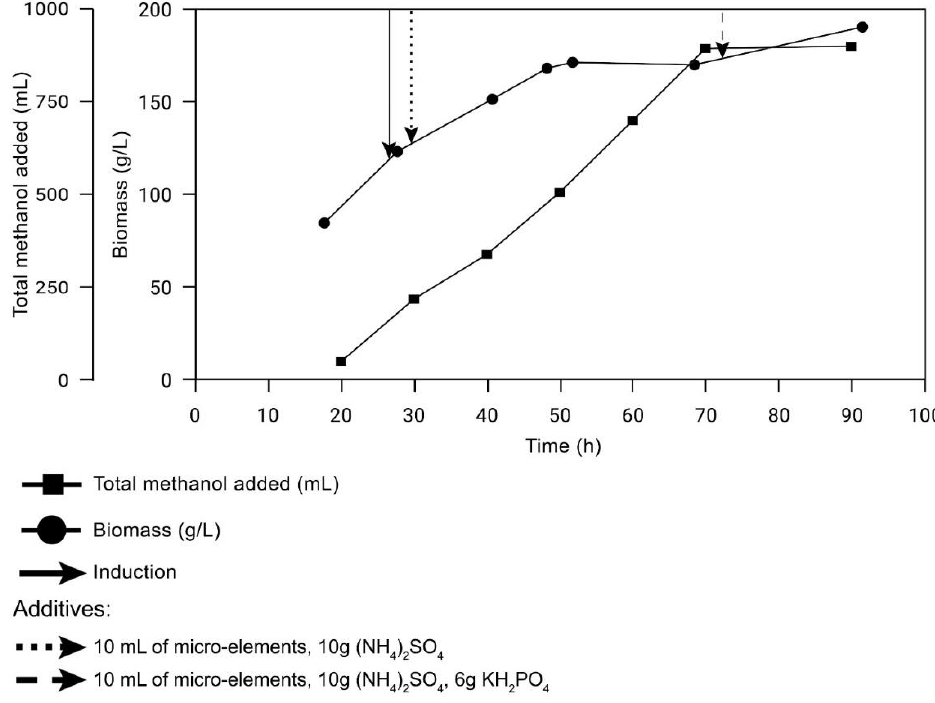
Figure 5. Condition of xAor growth in bioreactor.